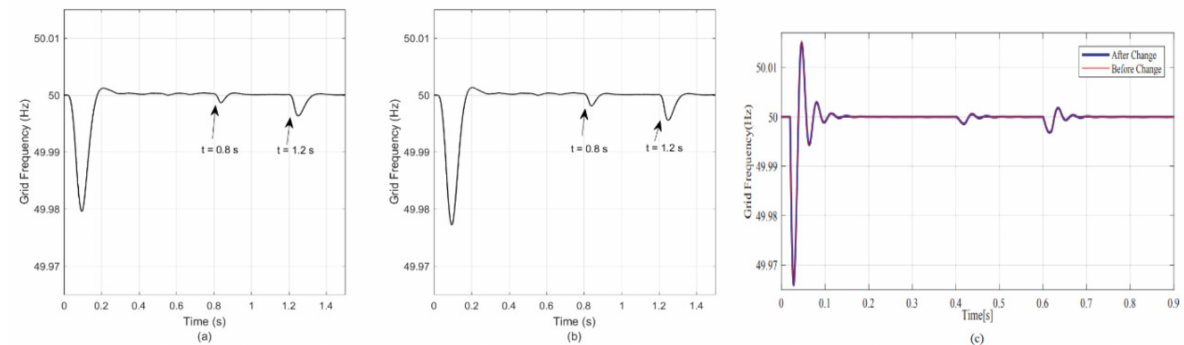
Figure 12. Frequency of grid with two different sets of MG parameters, ( a ) under the first set, ( b ) under the second set, ( c ) under two different sets of MG parameters in reference [19].